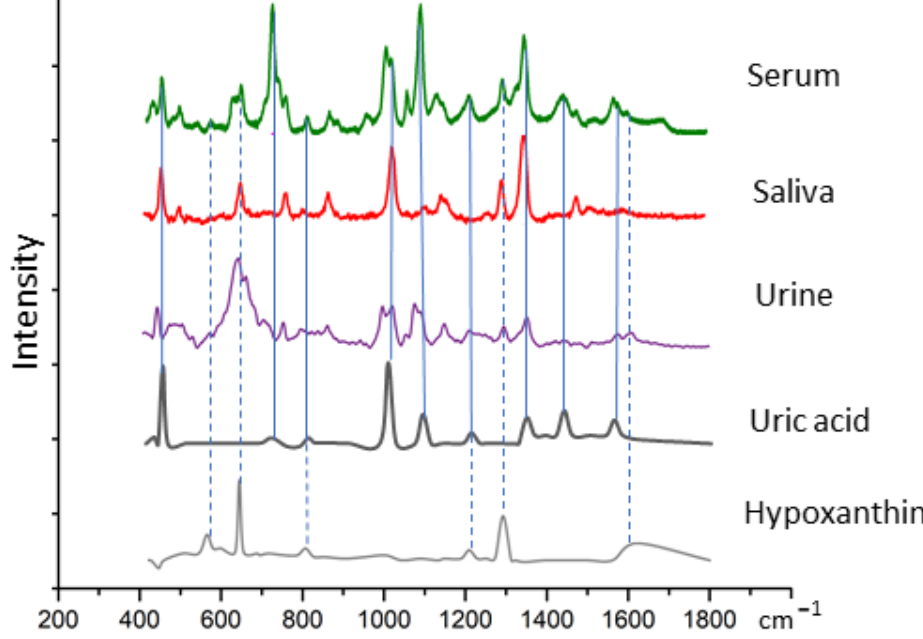
Figure 8. Overlap of spectra of 3 kDa filtrates of human serum, saliva and urine with uric acid and hypoxanthine. The intensity of peaks and highest overlap peak in body fluids and uric acid and hypoxanthine. The overlap peaks with uric acid in solid blue line. The overlap peaks with hypoxanthine in vertical dash blue line. The assignment of peaks is provided in Table 1.